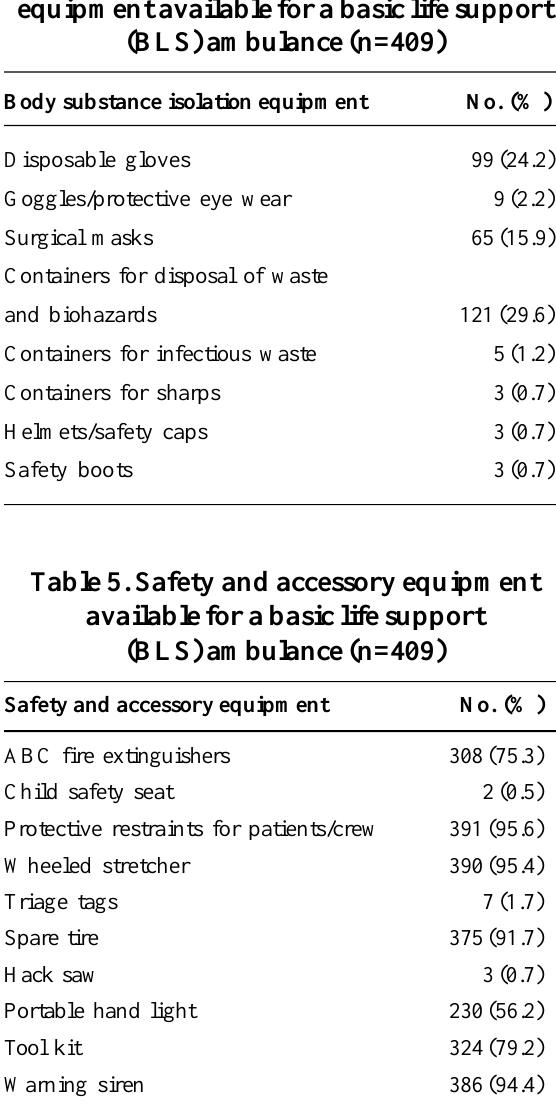
equipment available for a basic life support